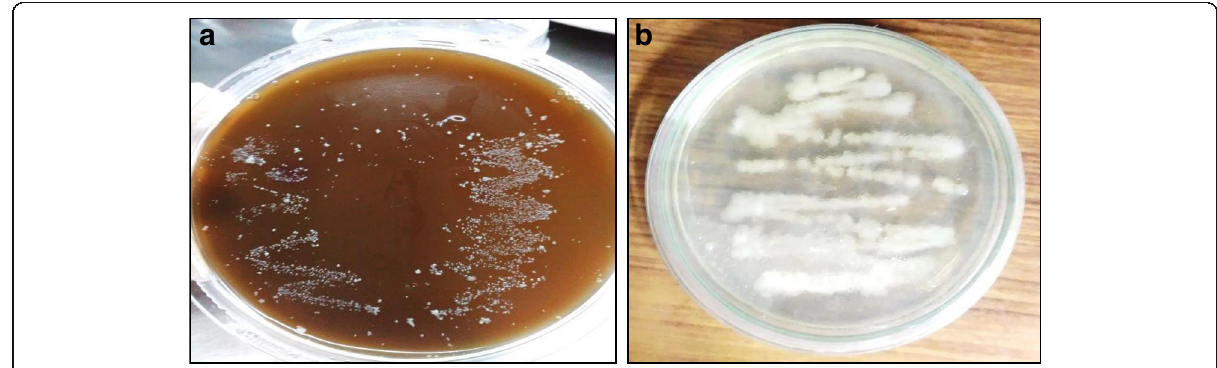
Fig. 1 The pictorial presentation of test pathogen a Culture of P. acne , an anaerobic bacteria, growth maintained on anaerobioc blood agar supplemented with fresh sheep blood. b culture of S. epidermidis an aerobic bacteria, growth maintained on Muller Hinton